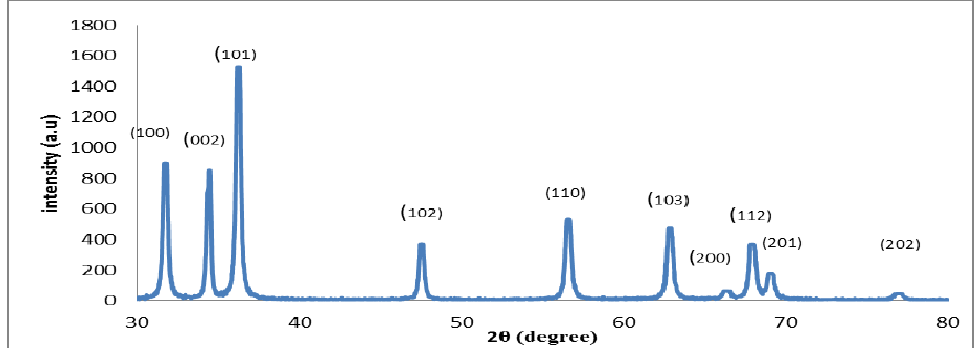
Fig. 1: XRD patterns of ZnO nanostructures synthesised using 2.5 M NaOH concentration by hydrothermal method.